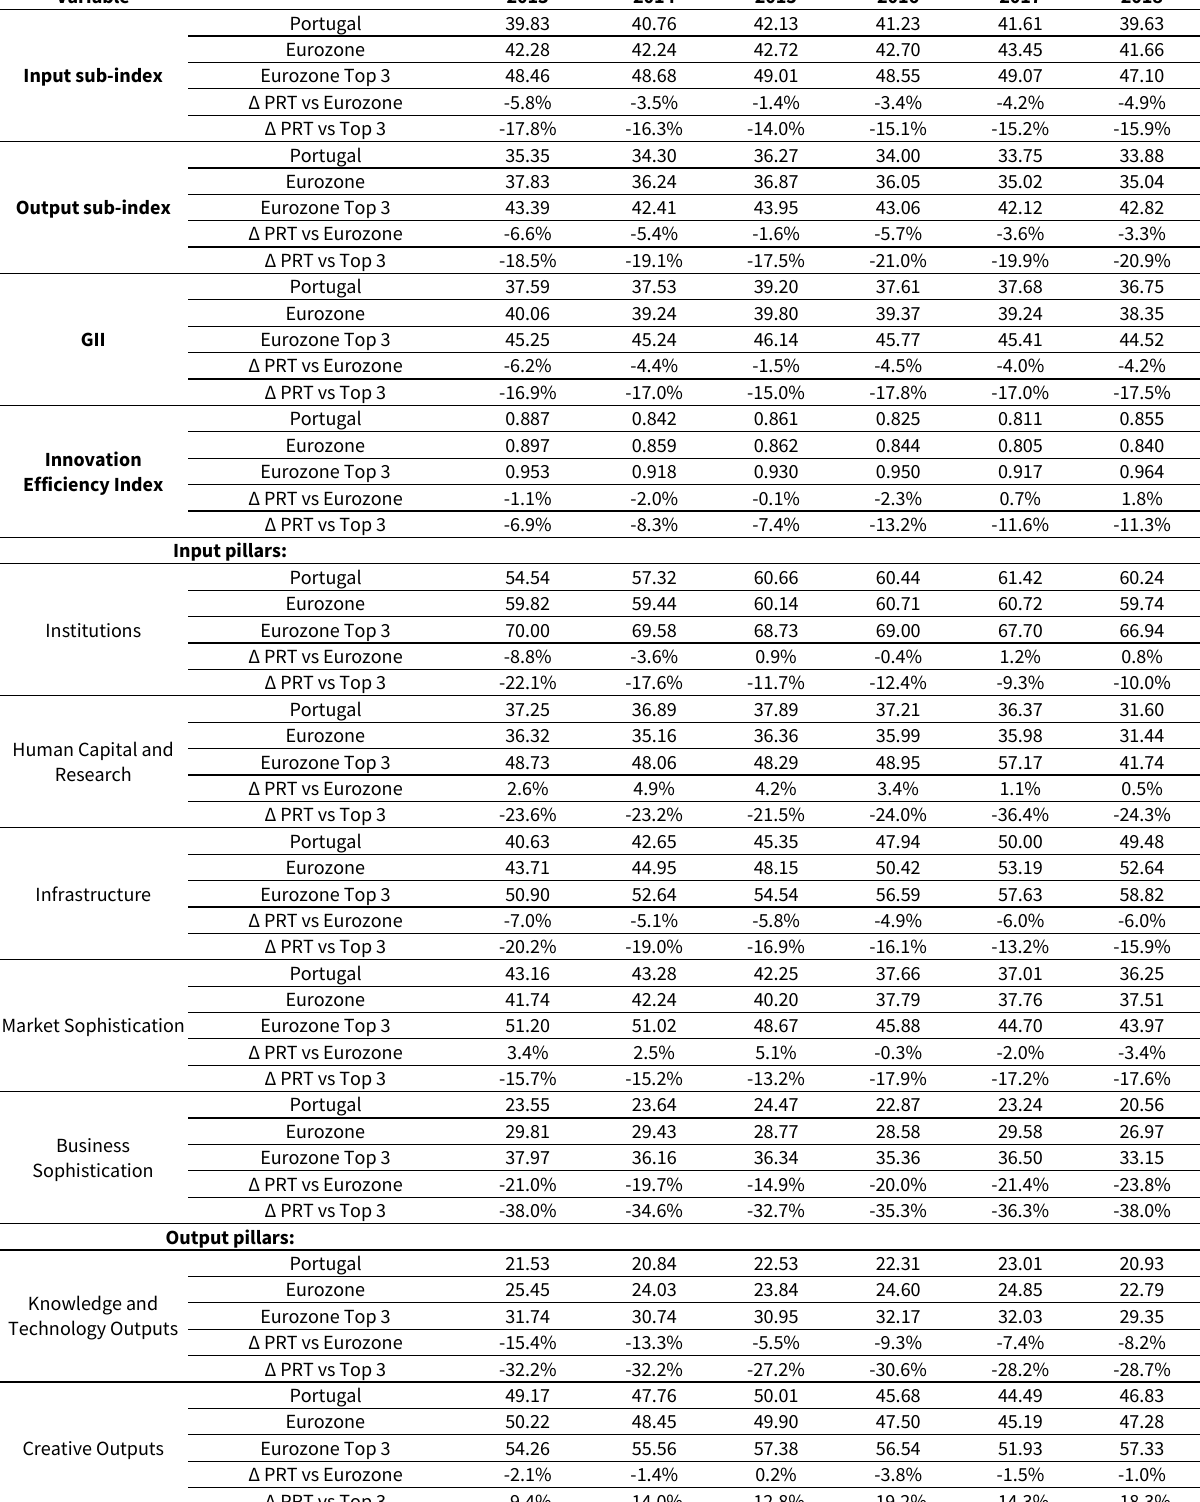
Table 5. Portugal yearly scores versus Eurozone and Eurozone Top 3 means